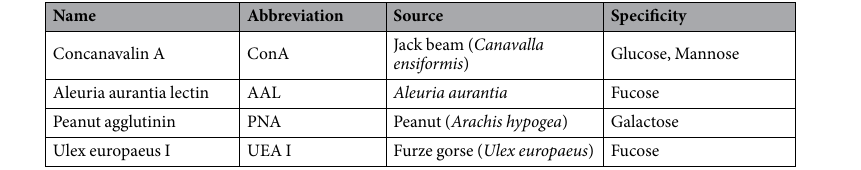
Table 2. Summary of lectins and their specificity used in this